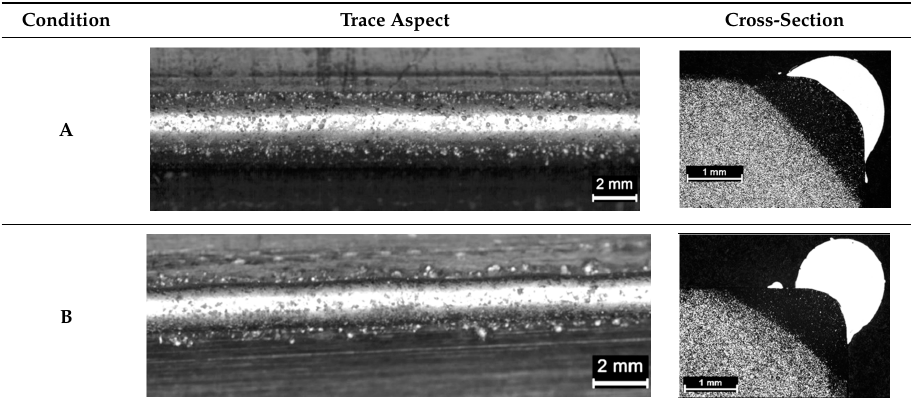
Table 9. Trace surface aspect and corresponding cross-section for deposition over edges.